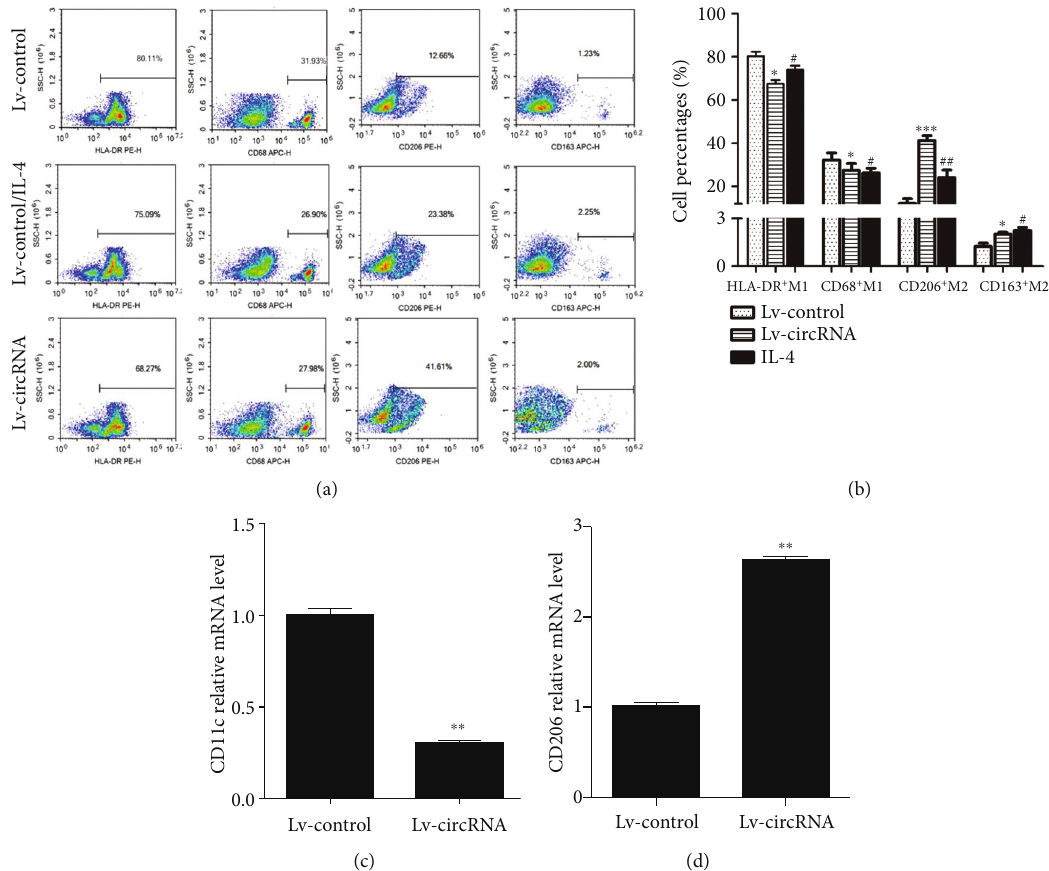
Figure 6: circRNA_17725 promoted macrophage polarization towards M2. (a) Flow cytometry: circRNA_17725 promoted CD206 + M2 and CD163 + M2 cells while inhibited HLA-DR + M1 and CD68 + M1 cells polarization (representative pictures). (b) Cell percentages of CD206 + M2, CD163 + M2, HLA-DR + M1, and CD68 + M1 cells determined by fl ow cytometry (vs. Lv-control: ∗ P < 0 : 05 , ∗∗∗ P < 0 : 001 ; vs. Lv-control: # P < 0 : 05 , ## P < 0 : 01 ; n = 3 ). (c) CD11c mRNA expression was decreased in circRNA_17725-overexpressed Raw264.7 cells ( ∗∗ P < 0 : 01 ; n = 3 ). (d) CD206 mRNA expression was increased in circRNA_17725-overexpressed macrophages ( ∗∗ P < 0 : 01 ; n = 3